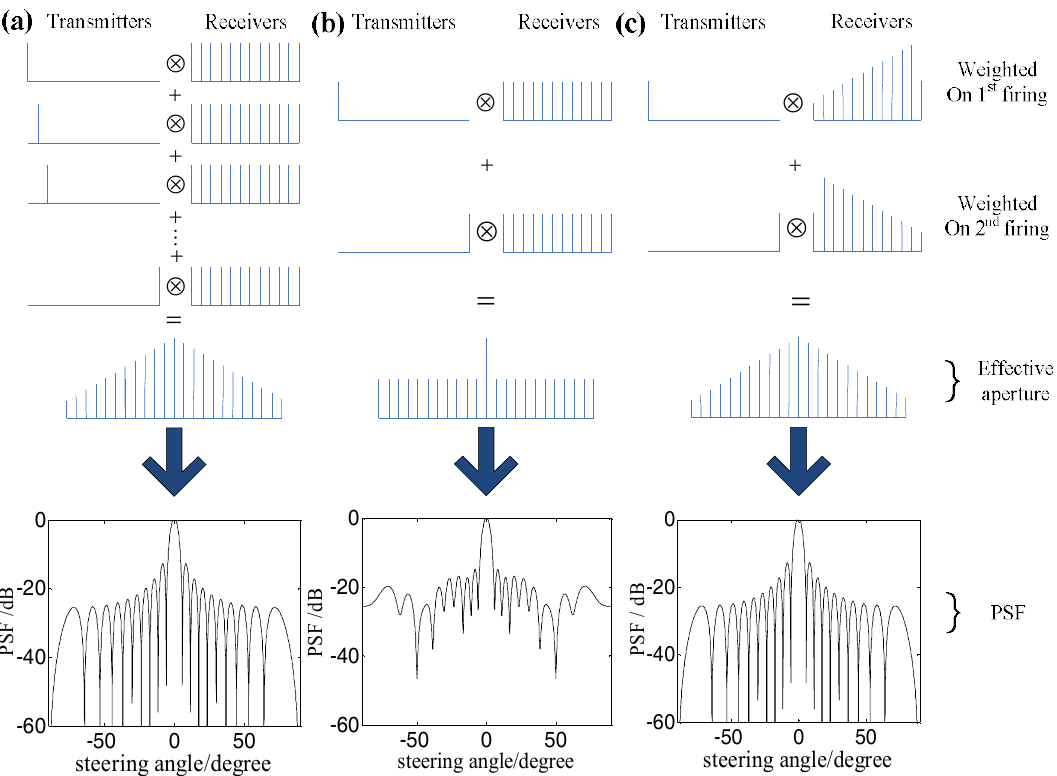
Figure 2. The array effective aperture and point spread function under different methods: ( a ) TFM; ( b ) sparse-TFM; and ( c ) corrected sparse-TFM.